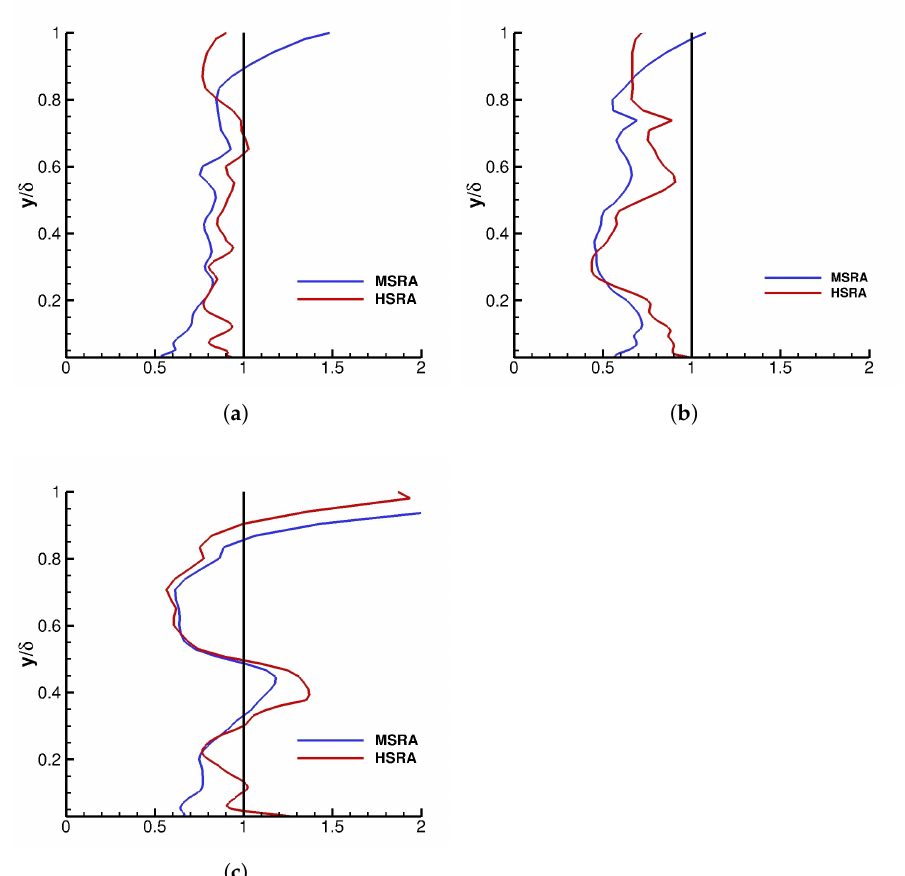
Figure 4. Effect of recycling-rescaling method on Strong Reynolds Analogy for Condition No. 2: ( a ) H t & p recycling-rescaling method. ( b ) Walz recycling-rescaling method. ( c ) T recycling- rescaling